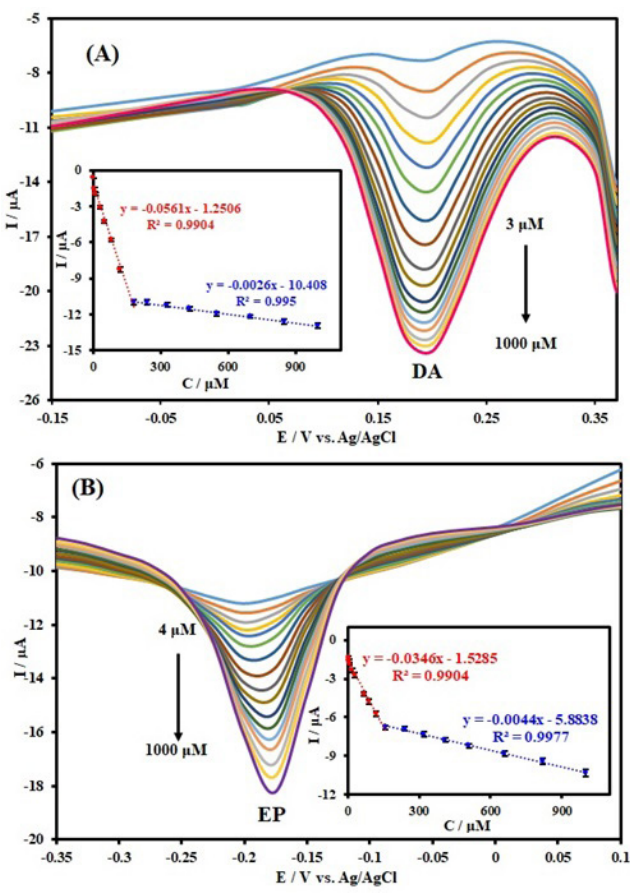
Fig. 10. DPVs of (A) different concentrations of DA (3-1000 µM) and (B) different concentrations of EP (4-1000 µM) at GCE/RGO/ TiO surface in 0.04 M BRS solution at pH 2